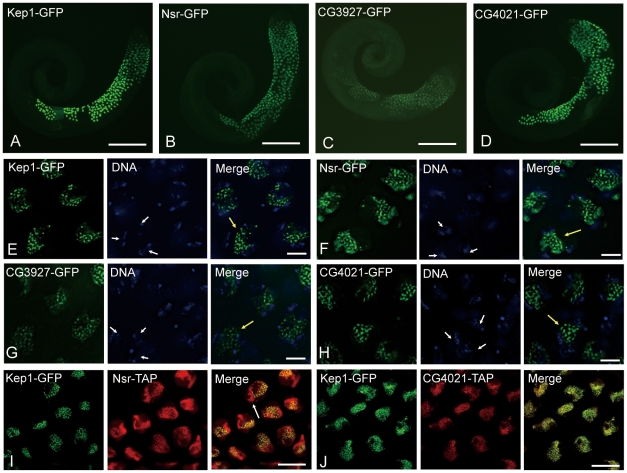
Expression analysis of kep1 family proteins by GFP transgene in D. melanogaster.(A–D) Low-magnification fluorescent images of transgenic GFP-fused Kep1 (A), Nsr (B), CG3927 (C), and CG4021 (D) proteins (green) in testes of D. melanogaster strain w1118. All of the kep1 family genes are enriched in the primary spermatocytes. (E–H) High-magnification fluorescent images of transgenic GFP-fused Kep1 (E), Nsr (F), CG3927 (G), and CG4021 (H) proteins in the primary spermatocytes. Proteins of kep1 family genes are located in the nuclear regions of the primary spermatocytes, which are distinguishable from the three diffusely staining nuclear regions (three white arrows), corresponding to the three main chromosome bivalents. Note that all kep1 family proteins are distributed in speckles (yellow arrow). (I and J) Comparisons of subcellular localization between Kep1 and new gene proteins. Kep1 is tagged with GFP (green); while Nsr and CG4021 are tagged with TAP (red), respectively. Nsr protein shows a wider expression region than Kep1 protein (arrow) (I), and CG4021 protein is completely co-localized with Kep1 protein (J). Scale bars: 200 µm for A–D; 10 µm for E–H; 50 µm for I and J.